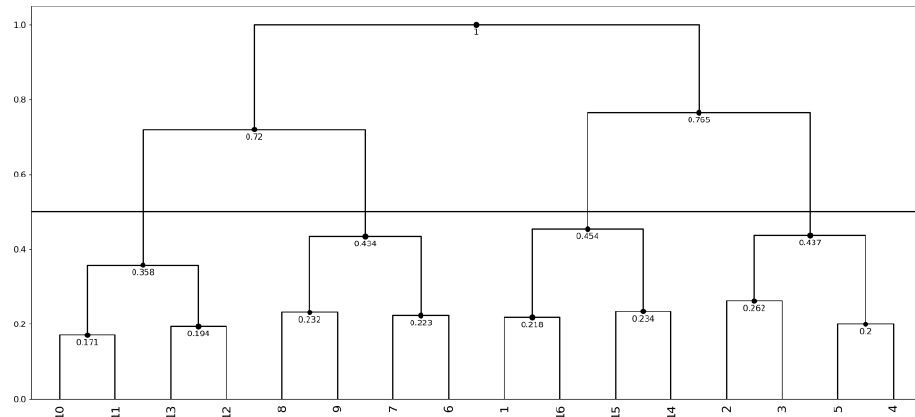
Figure 7. Dendrogram using the HCC for the first two features.